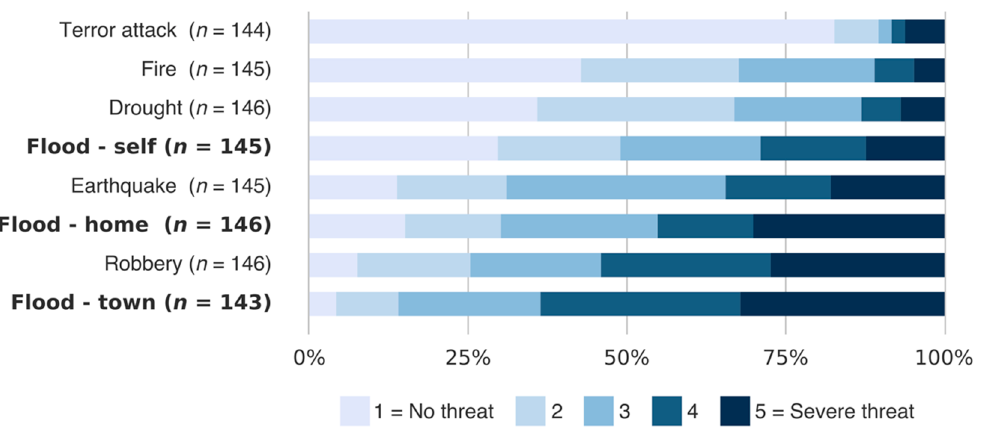
Figure 2. Survey results on perceived threat. 242